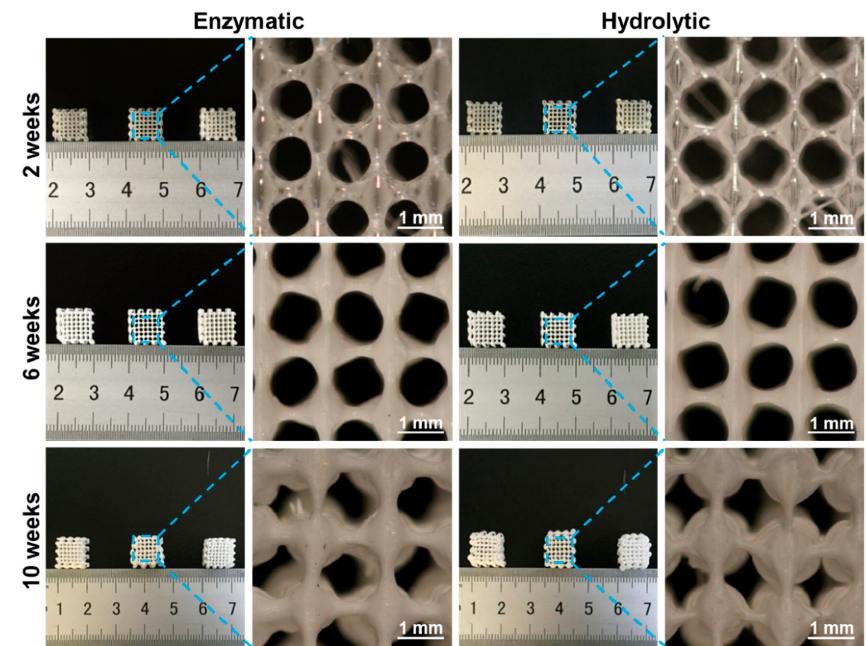
Figure 4. Macro-and-Micro-morphological view of the PLGA scaffolds, after enzymatic and hydrolytic degradation, at predetermined time intervals (2, 6, and 10 weeks of exposure time). The size of the scaffolds before degradation was 10 mm × 10 mm × 4 mm, with an area error of ±0.05 cm 2 , ( n = 5).